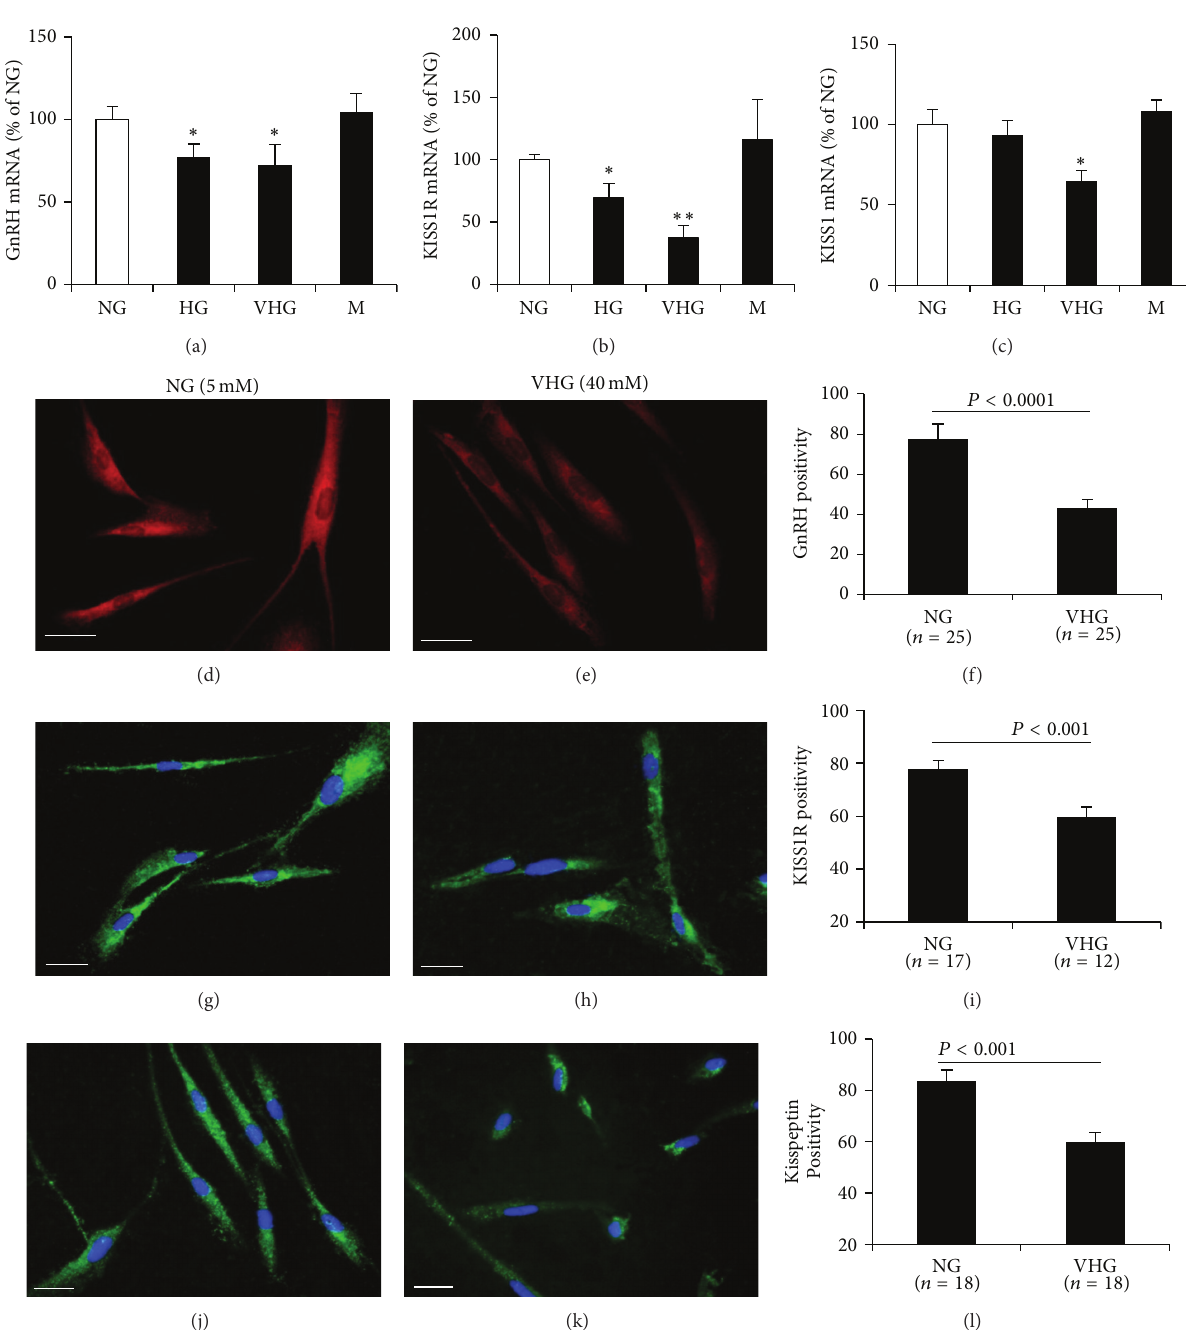
Figure 2: High glucose effects in FNCB4 cells. (a–c) Quantitative RT-PCR analysis of mRNA expression for GnRH (a), KISS1R (b) and KISS1, (c) genes in FNC-B4 cells exposed to normal (NG, 5 mM), high (HG, 22 mM), and very high (VHG, 40mM) glucose concentration or mannitol (M, 22 mM) for 24hours. Results were calculated according to the comparative Ct method, using 18S rRNA subunit as the reference gene for normalization and were obtained from three separate experiments, each performed in triplicate (𝑛 = 9) . Data are reported as mean ± SEM and are expressed in percentage (%) of NG. ∗ 𝑃 < 0.05 ; ∗∗ 𝑃 < 0.01 versus NG. (d–l) Immunofluorescent localization of GnRH (d, and e), KISS1R (g and h), and kisspeptin (j and k) proteins in FNC-B4 cells exposed to NG (d, g, and j) or VHG (e, h, and k). Dual labeling with the nuclear staining DAPI (blue color) and anti-KISS1R (green color; g and h) or anti-kisspeptin (green color; j and k) antibodies is also shown. Original magnification × 20; scale bar = 50 𝜇 m. Computer-assisted image analysis for quantification of GnRH, KISS1R, and kisspeptin immunopositivity is shown in panels (f), (i), and (l), respectively. 𝑛 = number of analyzed